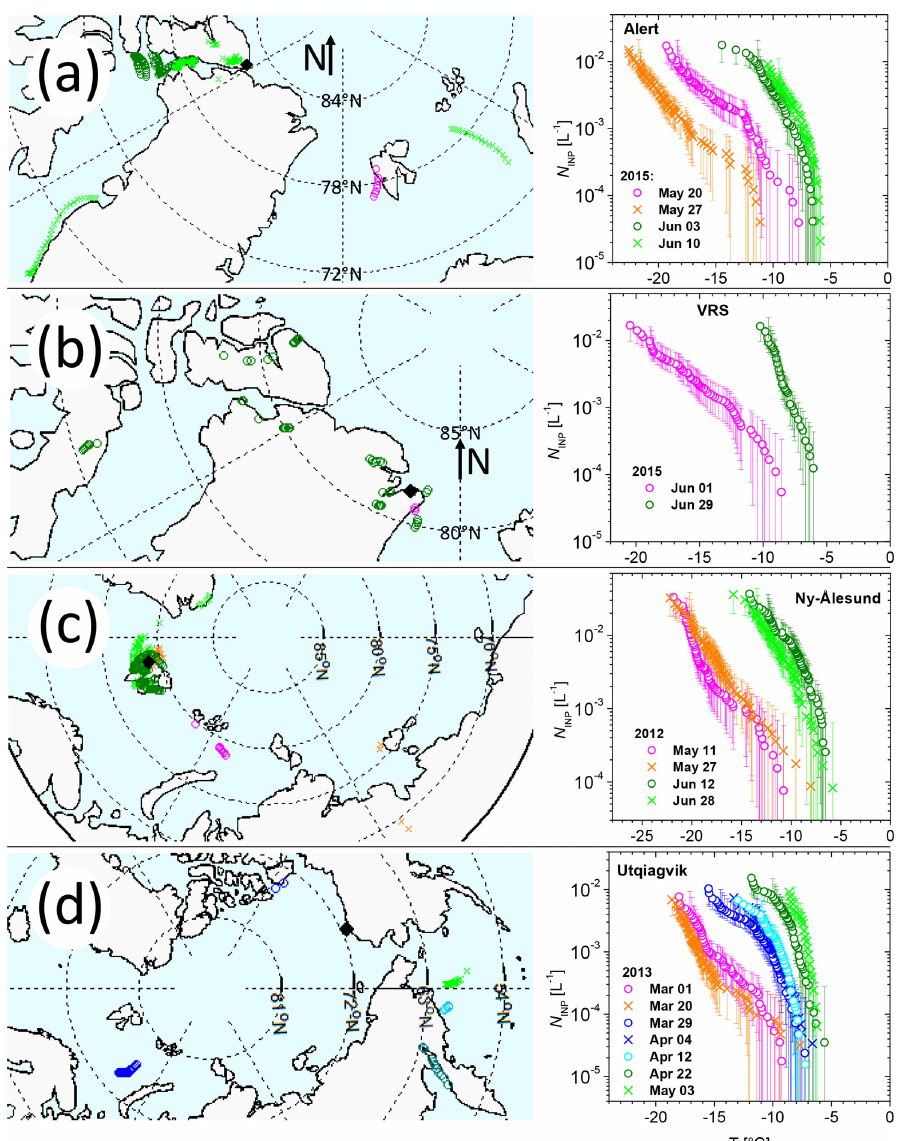
Figure 6. Panels (a) , (b) , (c) , and (d) each show a map on the left side in which locations are indicated where air masses collected on different filters crossed over open land or open water while being at a low altitude (below 100m for Alert, Ny-Ålesund, and VRS; below 500m for Utqia ˙ gvik). Black diamonds indicate the location of the measurement site. (Please note: the maps in c and d are rotated by 90 ◦ compared to the those in a and b .) The right side shows the INP spectra for the corresponding